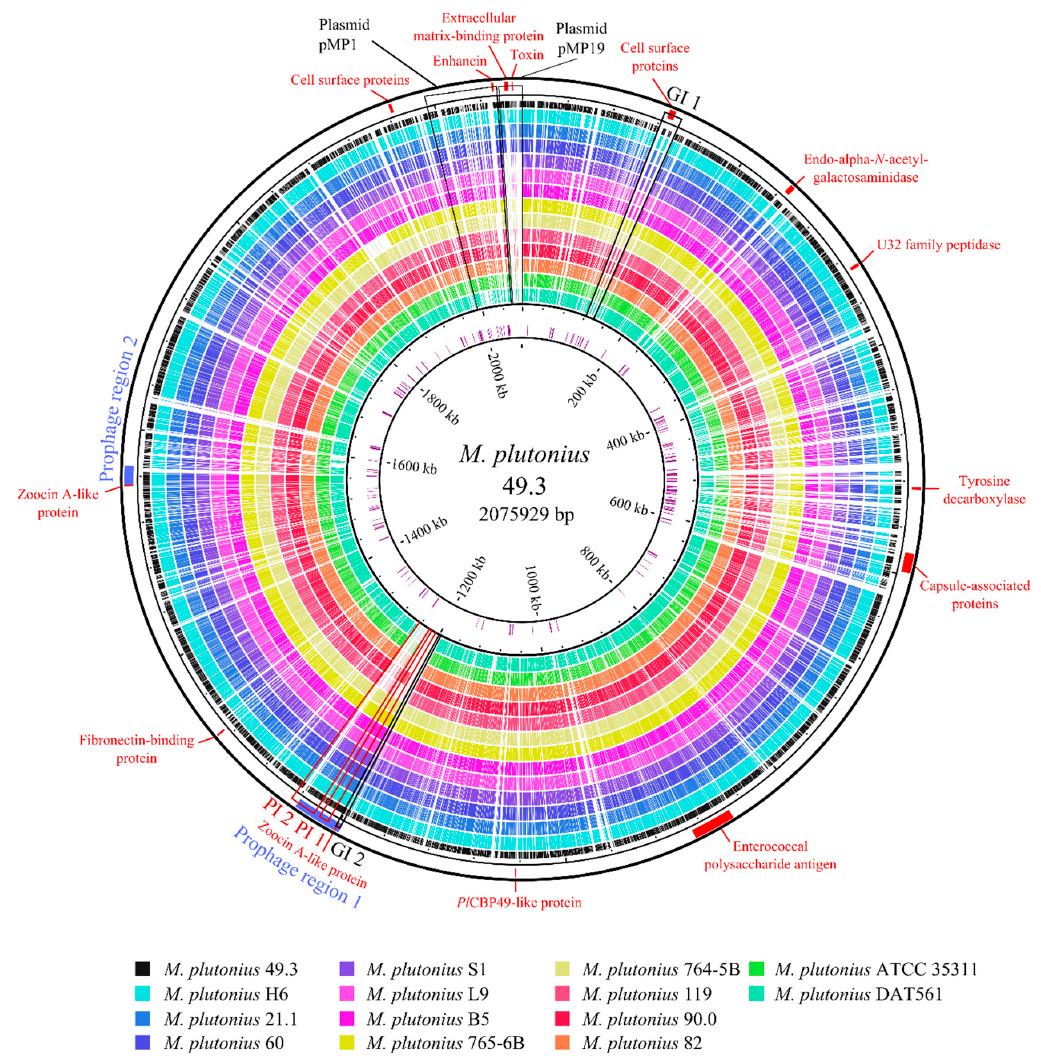
Figure 2. Circular genome map of M. plutonius 49.3. Comparison of the M. plutonius 49.3 genome to the genomes of strains H6, 21.1, 60, S1, L9, B5, 765-6B, 764-5B, 119, 90.0, 82, ATCC 35311, and DAT561 using the BRIG software [42]. The inner circle shows the positions of pseudogenes in the M. plutonius 49.3 genome, while virulence factors and prophage regions are depicted on the outer circle and are marked with red and blue blocks, respectively. Furthermore, pathogenicity (PI) and genomic islands (GI) are encircled and numbered in red and black. The plasmids pMP1 and pMP19 of M. plutonius 49.3 are indicated as well.